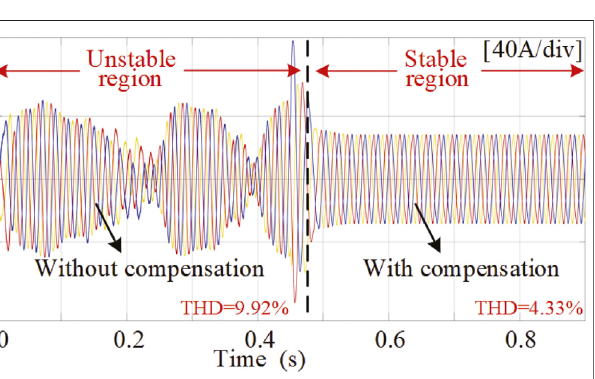
FIGURE 23 | Grid-connected current under very weak-grid.